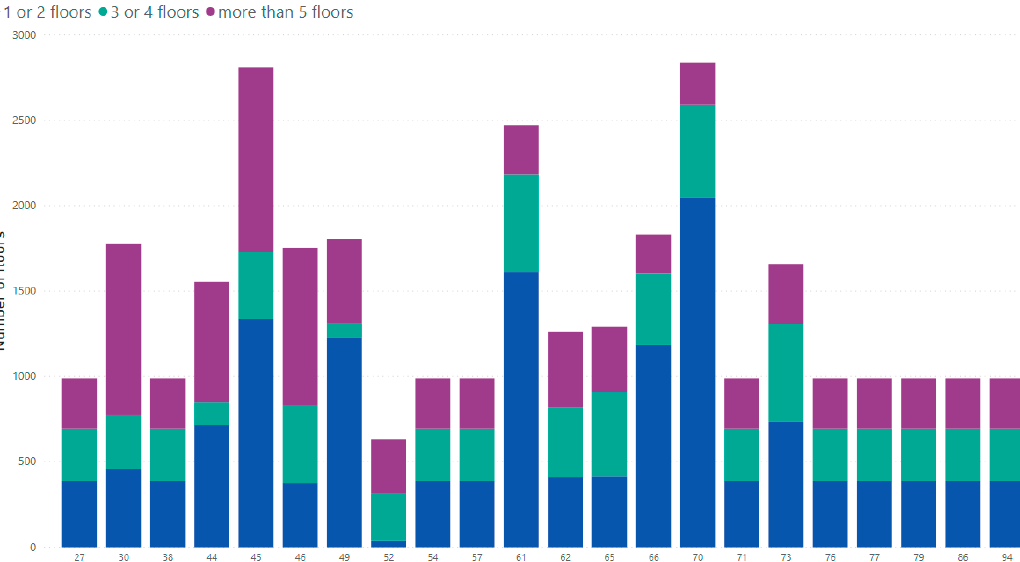
Figure 11. Distribution of the number of floors by building age. Table 2. Incident type versus variable importance from the data analytics performed, where +++ means higher intensity of occurrences ++ medium intensity of occurrences and + lower intensity of occurrences.